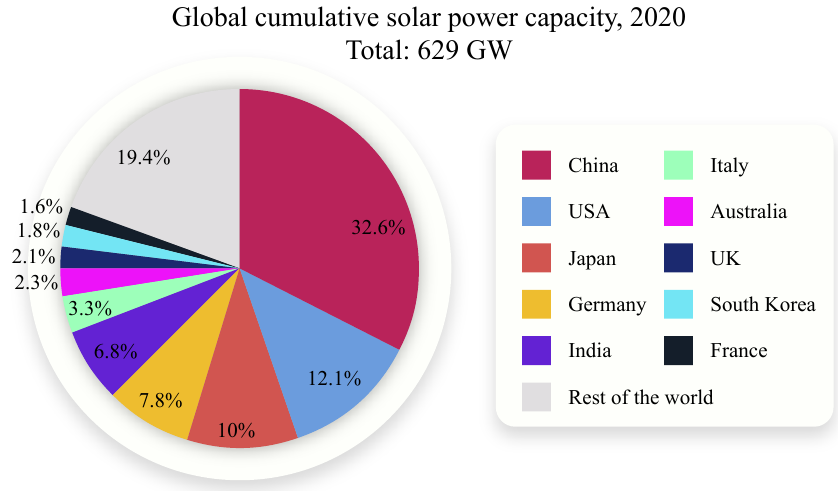
Figure 2. Cumulative solar power capacity by country in 2019. The top three countries China, U.S., and Japan account for more than 50% of the total installed capacity